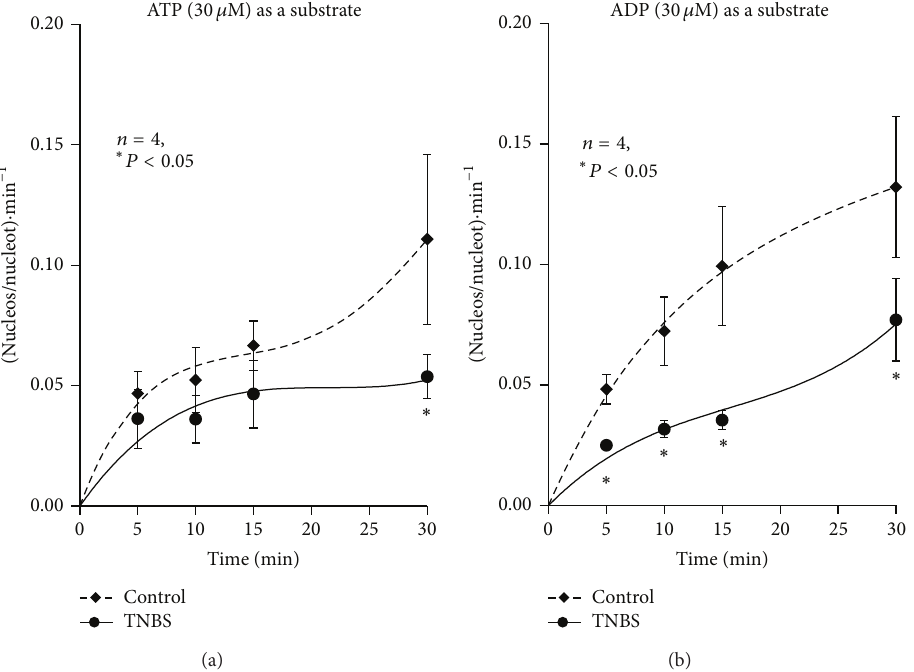
Figure 7: Activity of ecto-5 󸀠 -nucleotidase/CD73 when ATP (a) and ADP (b) were used as substrates of the ectonucleotidase cascade in the LM-MP of the ileum of control and TNBS-injected rats. ATP and ADP (30 𝜇 M) were incubated at zero time. Ecto-5 󸀠 -nucleotidase/CD73 activity was evaluated by quantifying the ratio [Nucleosides] : [Nucleotides]/min. Average results obtained in four experiments; the vertical bars represent the SEM and are shown when they exceed the symbols in size. ∗ 𝑃 < 0.05 (one-way ANOVA followed by Dunnett’s modified t -test) represents significant differences as compared to control